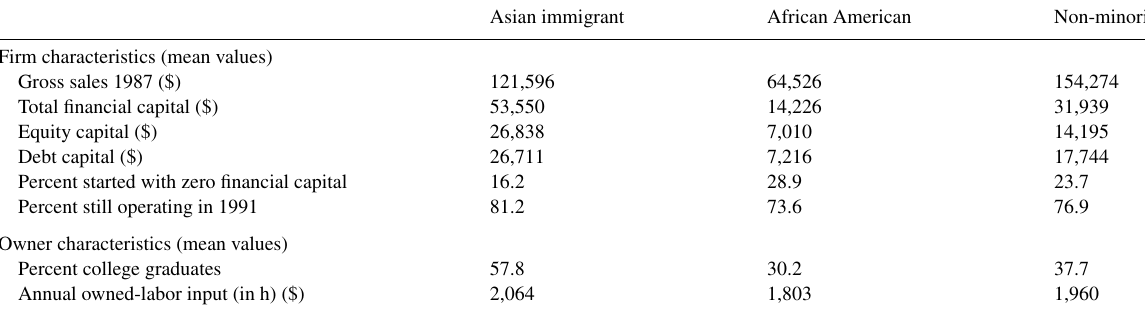
Table 5 Characteristics of firms nationwide: formed 1979–1987